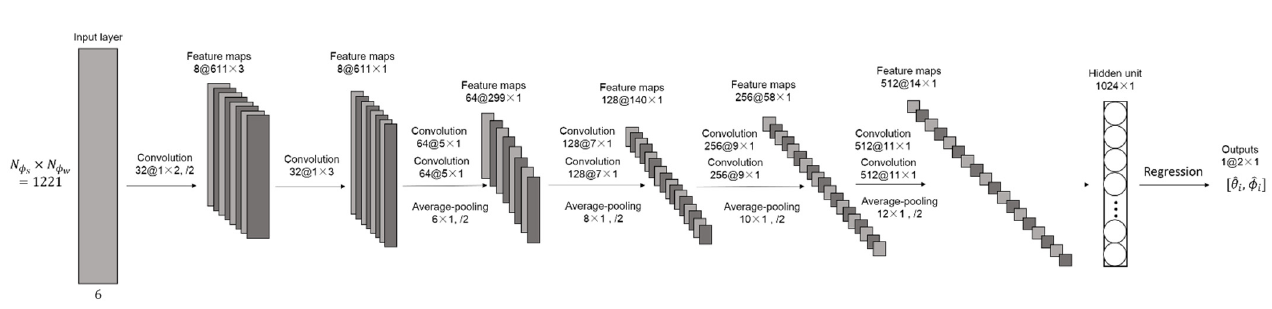
Figure 5. The CNN configuration employed for DOA estimation. The network is consisted of 10 convolutional layers, 4 average pooling layers, and a fully connected layer with 1024 hidden units.